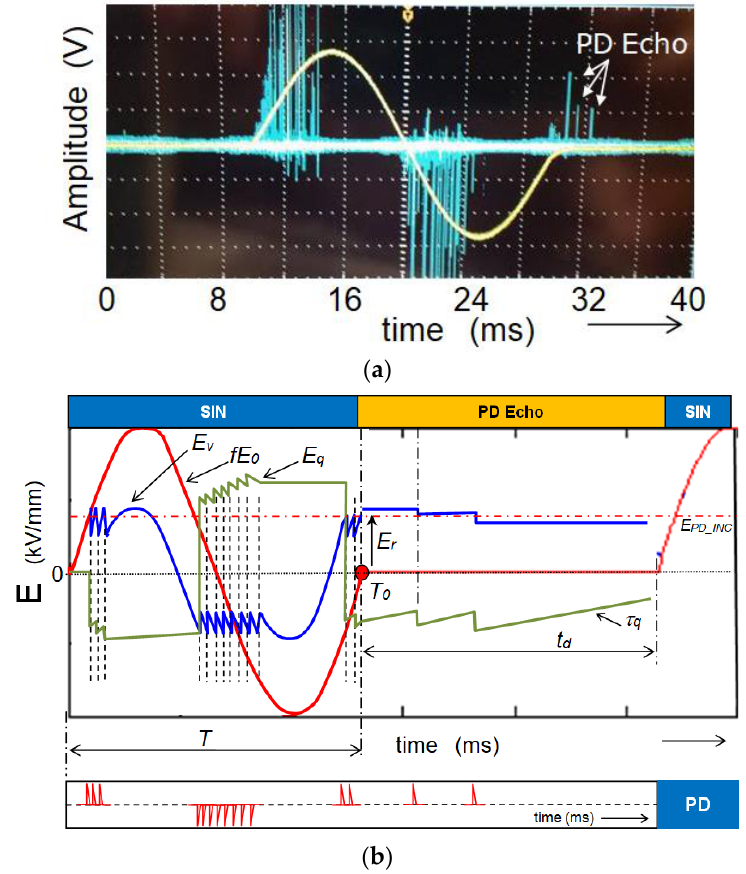
Figure 10. The PD Echo mechanism in a polar dielectric (when remnant field E r is present) with a PD pulse, prior to the transition point T 0 , ( a ) an exemplary PDE time-recording, ( b ) electric field waveforms.